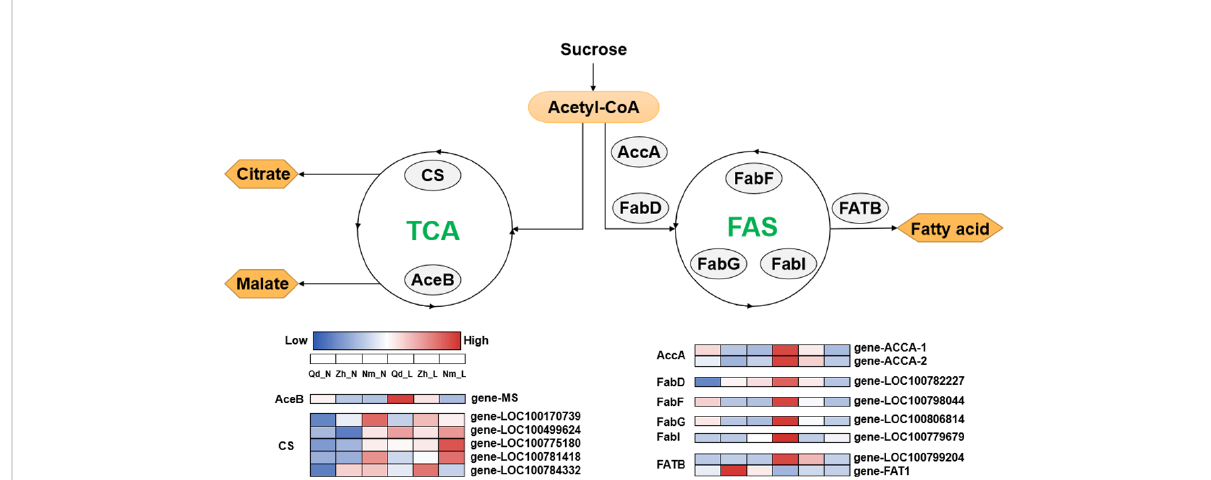
FIGURE 5 Deferentially expressed genes associated with the fatty acid biosynthesis and citrate cycle pathways. accA, acetyl-CoA carboxylase carboxyl transferase; FabD, [acyl-carrier-protein] S-malonyltransferase; FabF, 3-oxoacyl-[acyl-carrier-protein] synthase II; FabG, 3-oxoacyl-[acyl-carrier protein] reductase; FabI, enoyl-[acyl-carrier protein] reductase I; FATB, fatty acyl-ACP thioesterase B; AceB, malate synthase; CS, citrate synthase. The heat map shows the expression patterns of differentially expressed genes related to the fatty acid biosynthesis and citrate cycle pathways in Qd11, Zh13, and NM at different P treatments. Enzyme names are shown in the gray circle. The color bar from blue to red indicates upregulation; the color bar from red to blue indicates downregulation. Varieties abbreviations: Qd, Qian Dou 11; Zh13, Zhonghuang 13; Nm, Niu Mao Soybean; L, low soil phosphorus availability; N, normal soil phosphorus